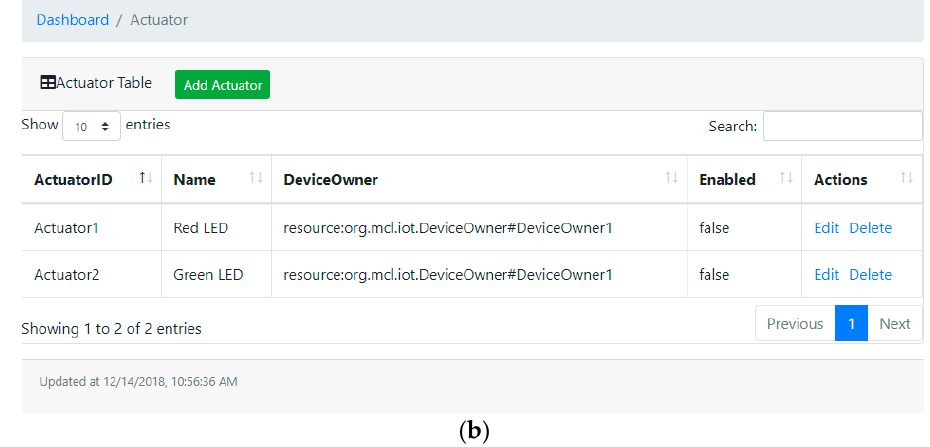
Figure 12. Snapshot of device dashboard. ( a ) Sensor dashboard; and ( b ) actuator dashboard.